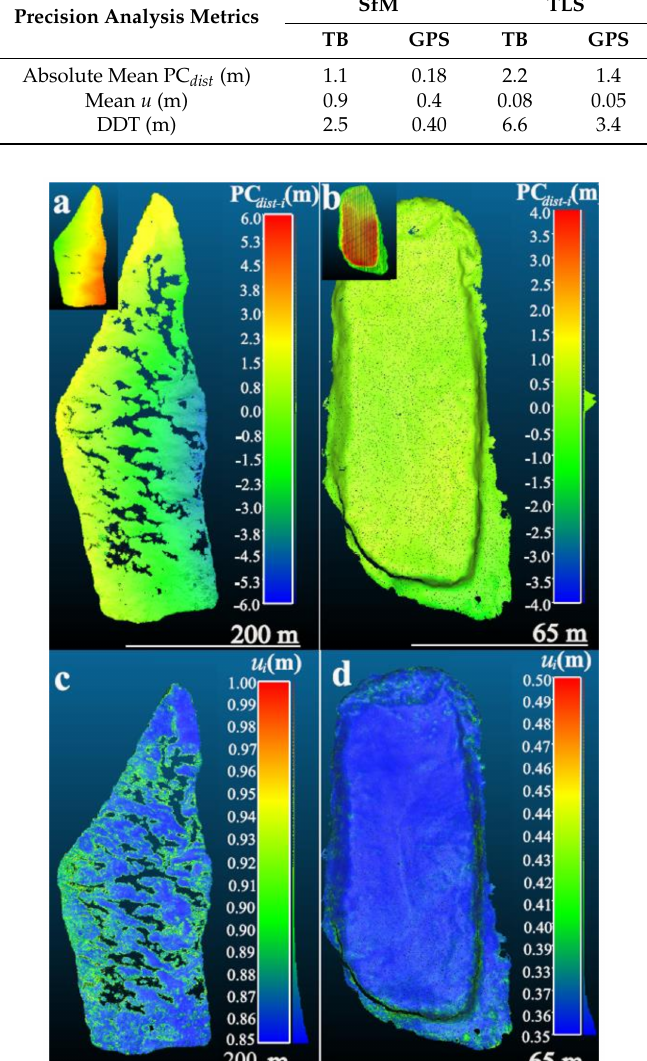
Figure 6. M3C2 algorithm output for SfM-generated point cloud comparison. ( a , b ) show the distance between triplicate point clouds (PC dist-i ) for i1 ( a ) and i2 ( b ), respectively. Uncertainty ( u i ) in these distances at the 95% confidence level is illustrated in panels ( c , d ) for i1 and i2, respectively. Histograms to the right of the colour scale bar depict the frequency of the corresponding values. The insets in panels ( a , b ) contain example point clouds of each iceberg before M3C2 point cloud differencing. Inset colours represent height values where red represents the higher elevations. Observed ice rubble was located in the region pictured at the top of the inset in ( b ). The ram (i.e., an underwater ‘foot’ or ‘skirt’ that often forms underneath the waterline) likely became exposed at the opposing side of i2. The low elevations at the bottom of the inset represent the ram. Note the variation in scale between panels and in comparison to Figure